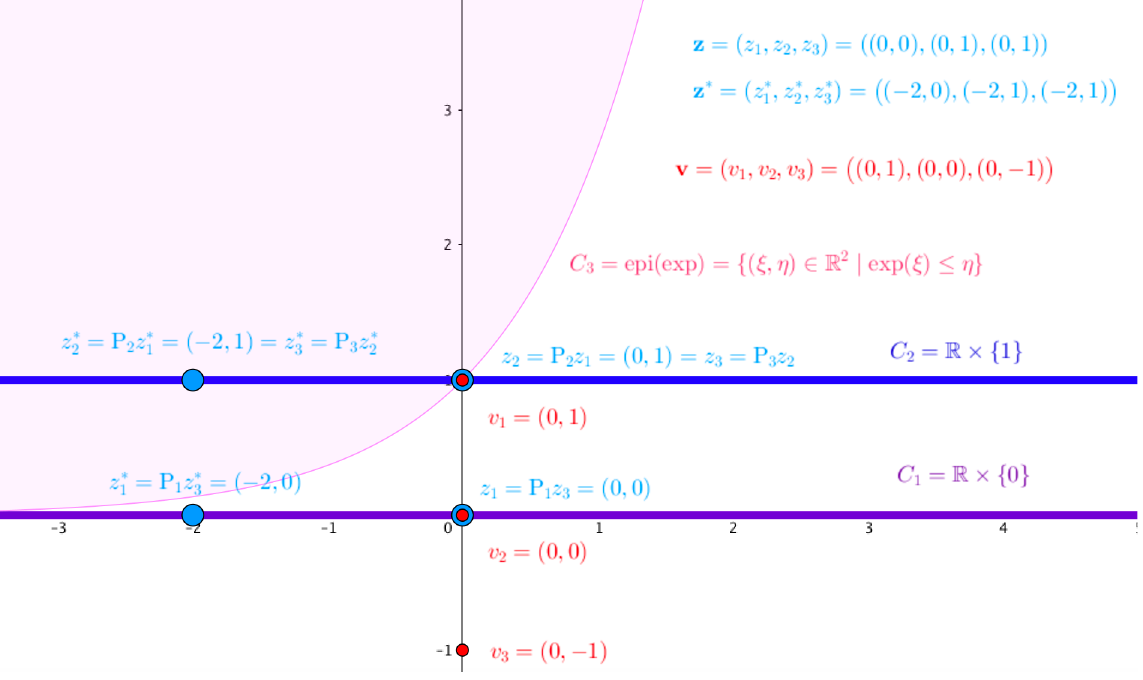
Figure 3 Visualization of the case of two lines and the epigraph of the exponential function where there are cycles. See Section 5.2 for